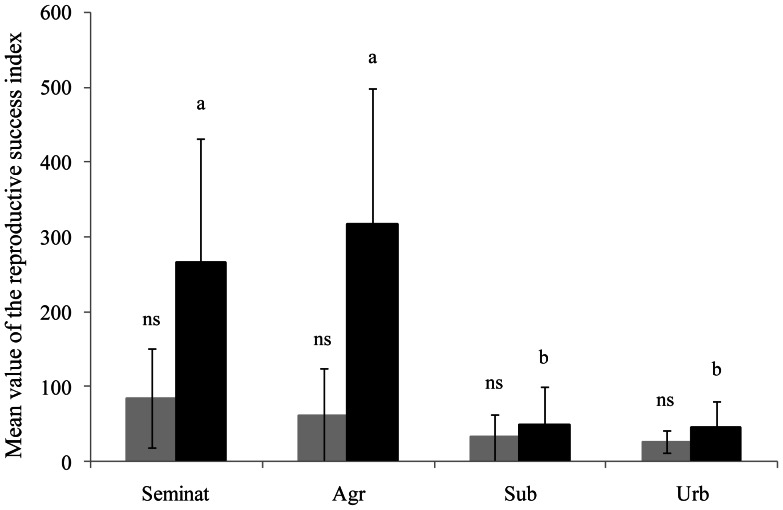
Mean reproductive success index of plant morphological groups according to the landscape context.Black bars: open flowers morphological group. Grey bars: tubular flowers morphological group. Lines above bars denote 95% confidence interval. Bars that do not share the same letter show significant differences (P<0.05). NS: no significant differences (P>0.05). Seminat: Semi-natural; Agr: Agricultural; Sub: Suburban; Urb: Urban.